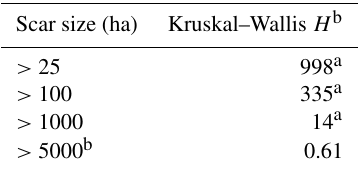
Table 3. Tests statistics with respect to three-way differences in burned-area scar size frequency distributions for Sentinel, MODIS, and official estimates.